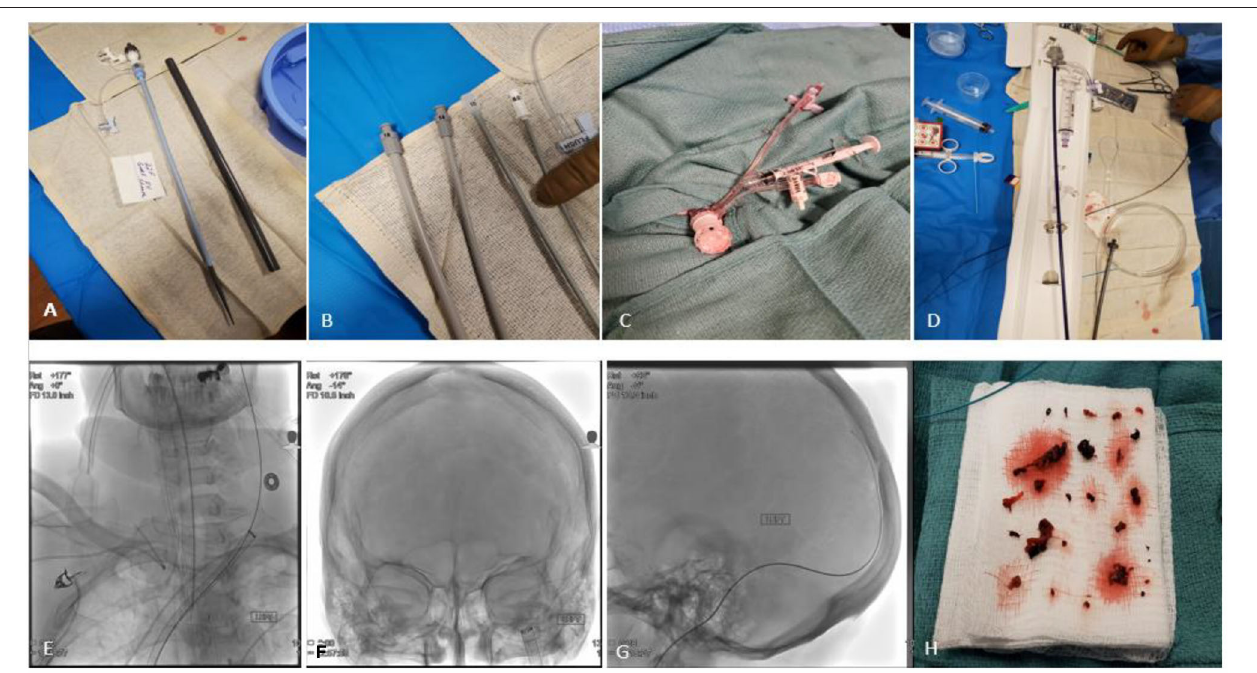
FIGURE 2 | Transvenous endovascular mechanical thrombectomy using the INARI FlowTriever system. (A–C) Right femoral venous access was obtained by placing a 22F GORE DrySeal Flex Introducer Sheath with pre-dilation using 8F, 10F, 14F then 18F dilators. 2 cc of air was inflated in the GORE DrySeal Flex valve to stop back flow of venous blood. (D,E) After selecting the left internal jugular vein; The INARI Triver20 large bore aspiration catheter was advanced with its dilator over the TAD2 exchange wire (Over-the-wire technique) and then the dilator was removed. (F–H) large volume venous clots retrieved using the Vect074 reperfusion catheter and Solitaire stent retriever and negative pressure applied with a 60 cc syringe through the INARI Triver20 large bore aspiration catheter. Anticoagulation with heparin was resumed after the